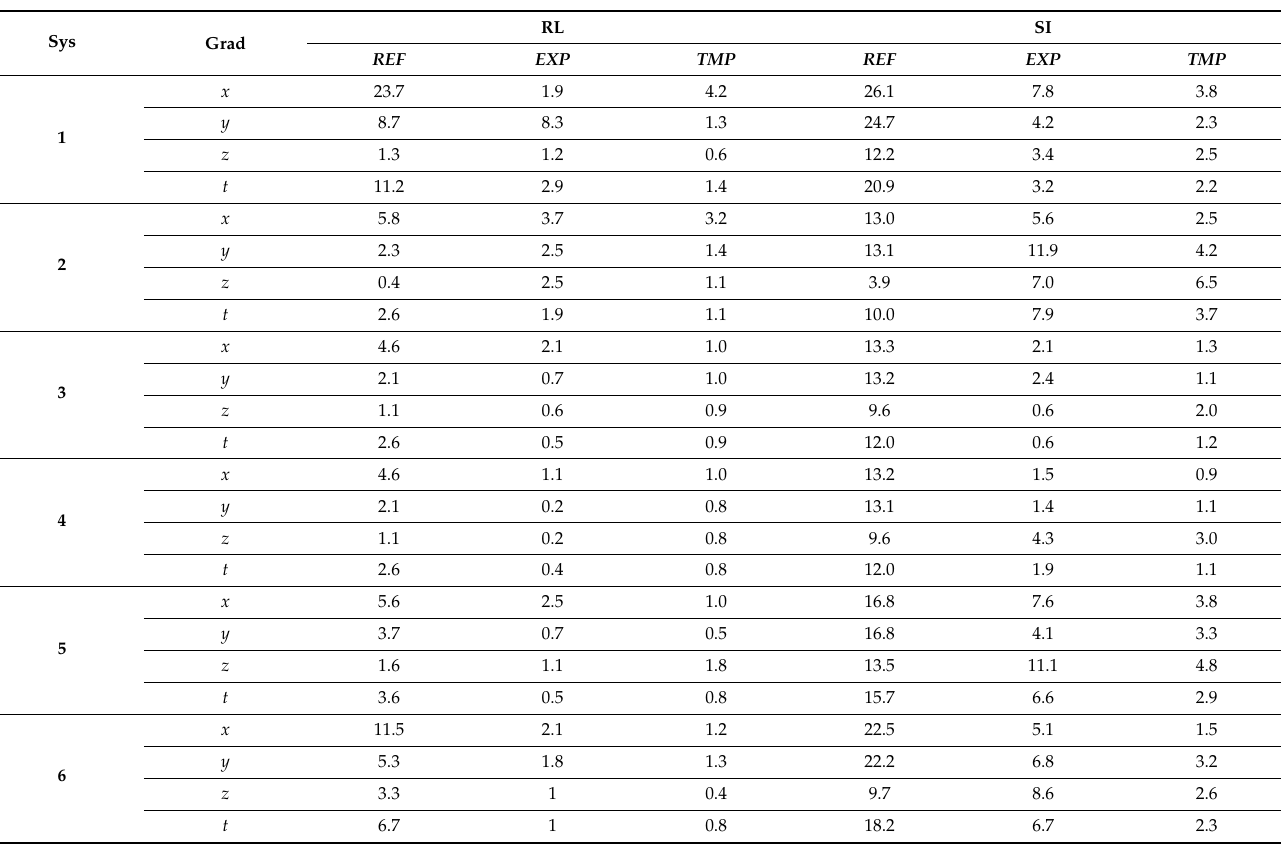
Table 1. Summary of spatially averaged % RMSD i ( i = REF , EXP , TMP ) for horizontal (RL) and along-the-bore (SI) offsets of three physical ( x , y , z ) gradient channels and the trace ( t ) from six studied gradient platforms